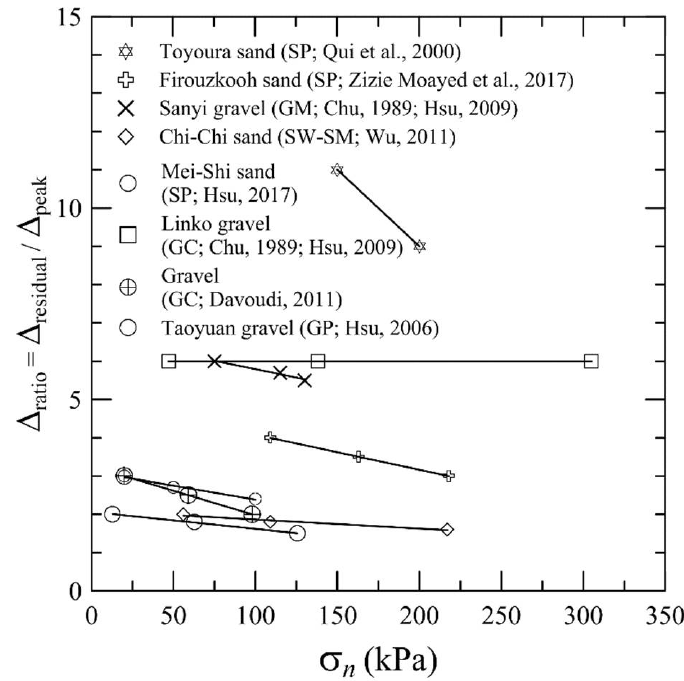
Figure 5. Experimental values of Δ ratio obtained in various studies. Figures 6 and 7 compare experimental and simulated shear stress vs. displacement curves for the tests reported by Wu [18] and Hsu [19], respectively. The input parameters used for simulating the stress-displacement curves in these figures are summarized in Tables 1 and 2, respectively. It can be seen that the simulated pre-peak and post-peak curves agree well with the experimental ones.